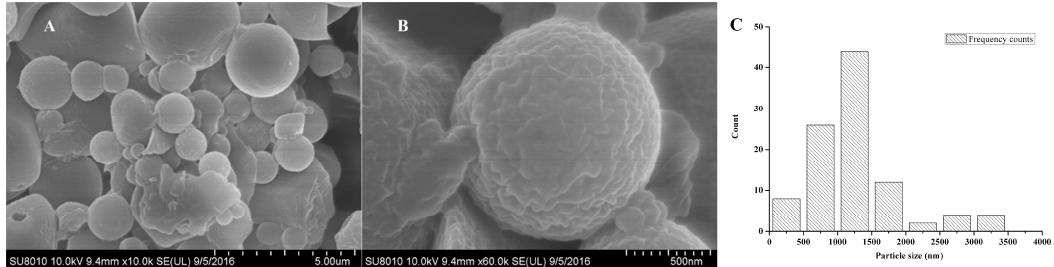
Figure 5. SEM images of pyraclostrobin microcapsules (( A ) scale bar of 5.0 μ m; ( B ) scale bar of 0.5 μ m) and the histogram of particle size distribution ( C ).